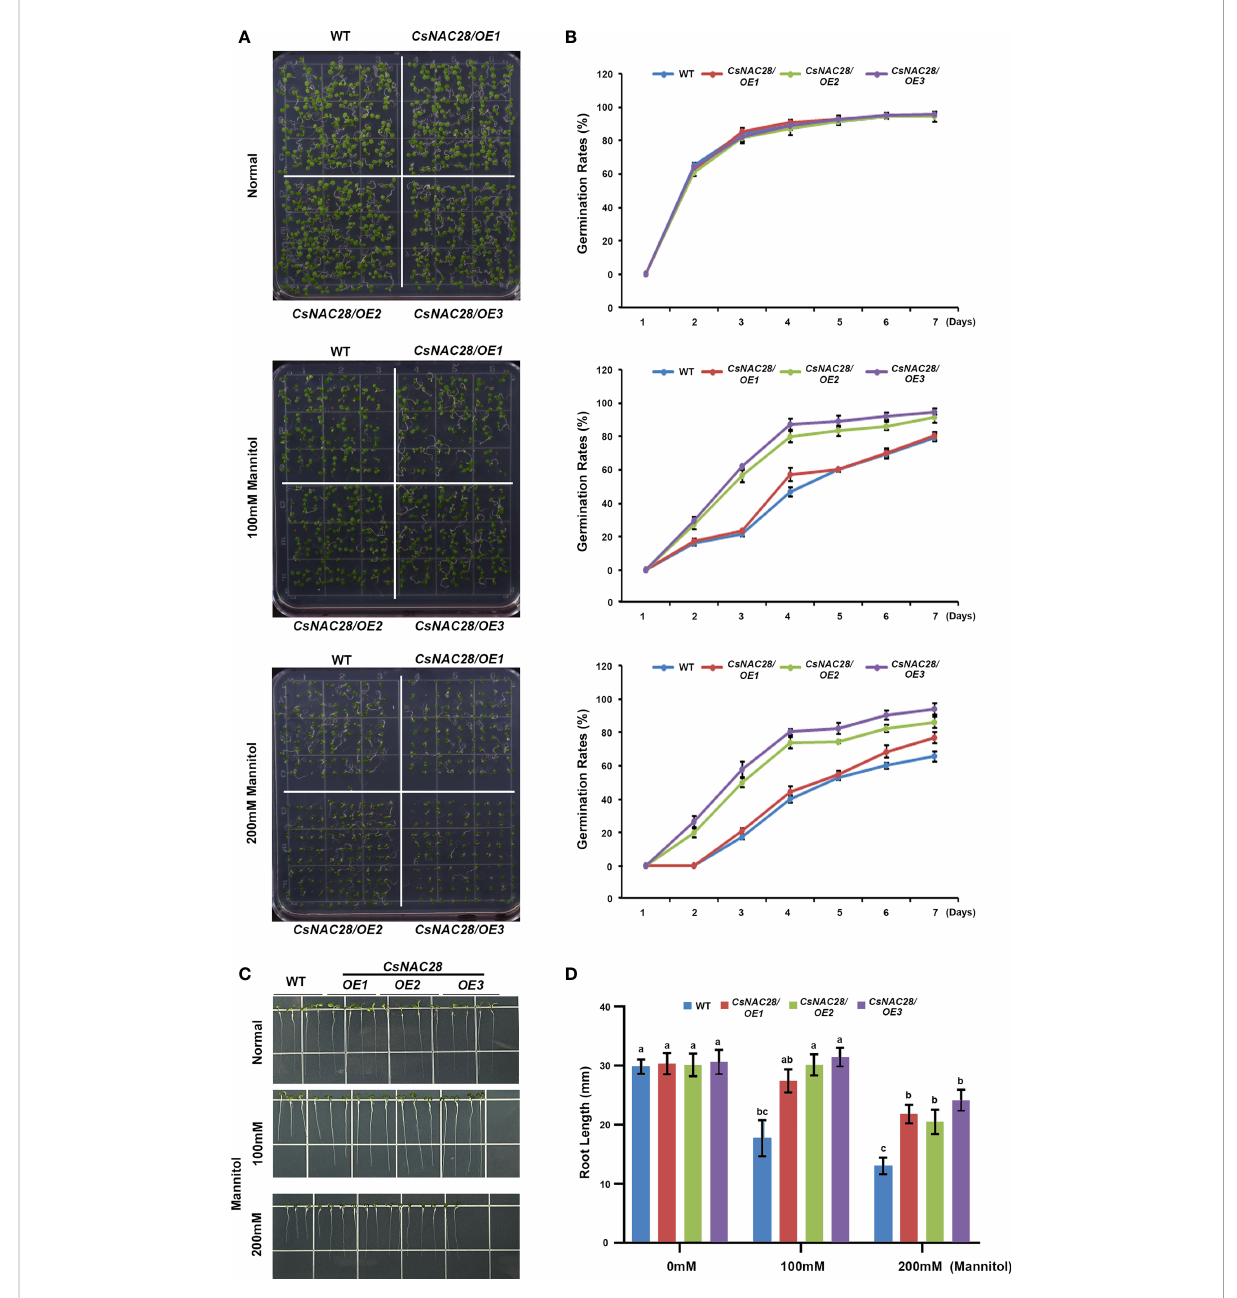
FIGURE 8 CsNAC28 overexpression promotes seed germination under simulated drought conditions. (A) Germination assay under different concentrations of mannitol treatments. (B) Germination percentage of each line after 7-day simulated drought treatment. (C) Root elongation assays under different concentrations of mannitol treatments. (D) Quanti fi cation of root length under different concentrations of mannitol treatments. Different letters indicate signi fi cant differences at